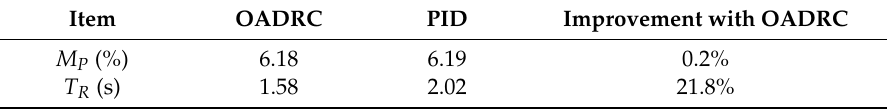
Figure 16. Disturbance rejection performance comparison with step change of variable-geometry turbocharger (VGT) vane. Table 9. Disturbance rejection performance comparison with step change of VGT